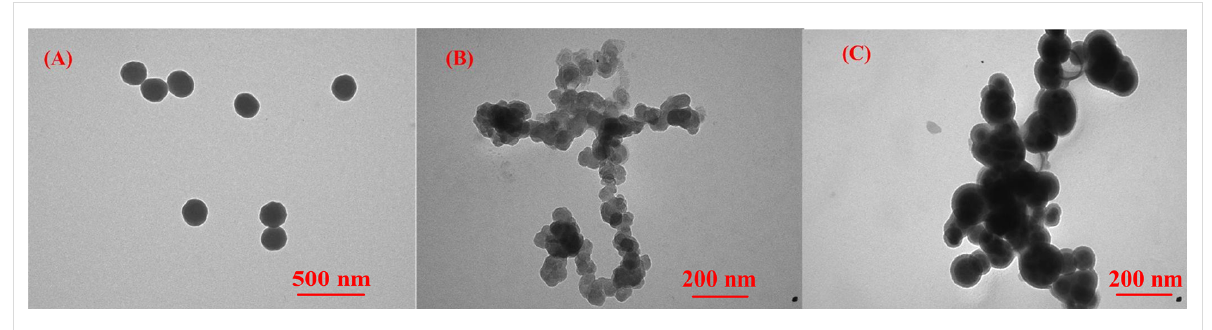
Figure 2: TEM images of P1 (A), P2 (B) and P3 (C) micelles.